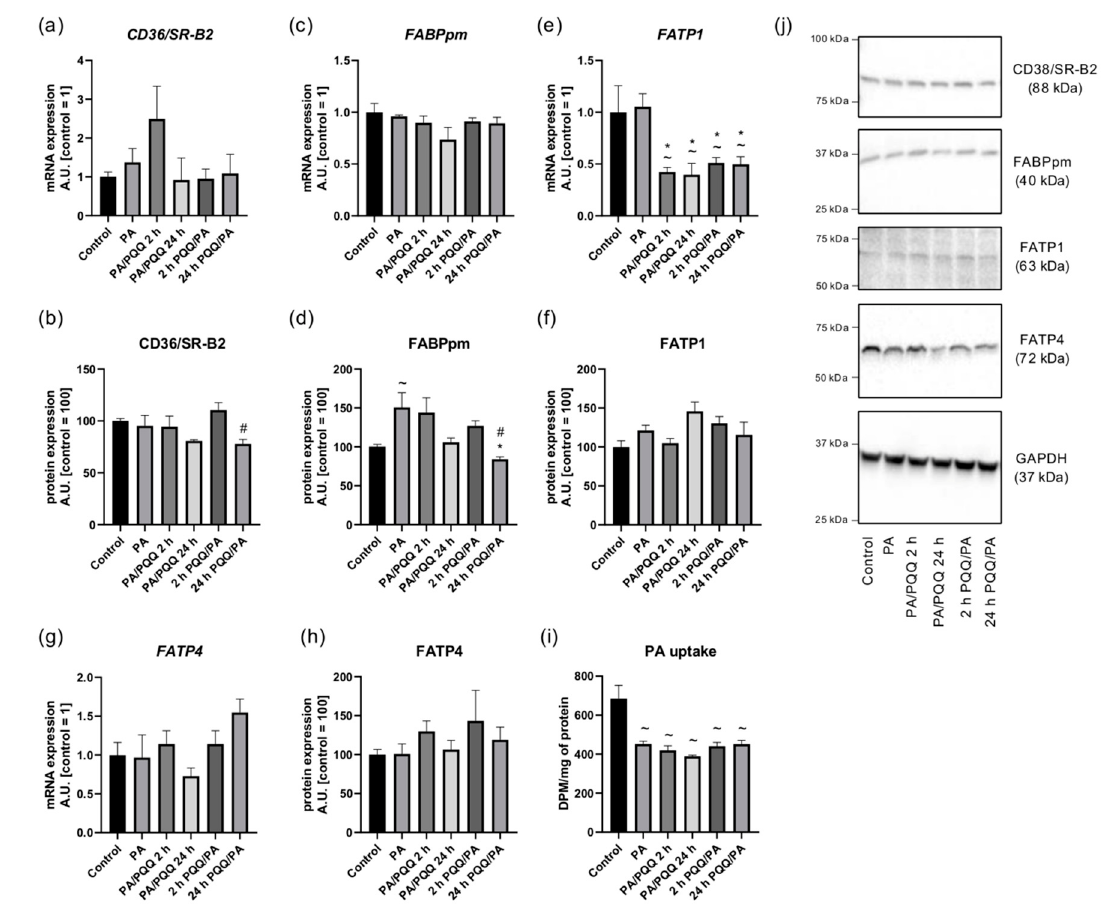
Figure 3. E ff ects of short- and long-time incubation with PQQ on the mRNA and protein levels of ( a,b ) cluster of di ff erentiation 36 / scavenger receptor class B protein, ( c,d ) plasma membrane-associated fatty acid binding protein, ( e,f ) fatty acid transport protein 1, ( g,h ) fatty acid transport protein 4 as well as ( i ) palmitic acid uptake. ( j ) Representative Western Blot data. Unless stated otherwise, the control is set as 1 (mRNA) or 100 (protein). The values are presented as mean ± SEM based on six independent determinations. ANOVA with a post hoc Tukey’s test was applied. ~ p < 0.05, study groups versus control; * p < 0.05, PQQ-incubated groups versus palmitate group; # p < 0.05, time-dependent di ff erences (long- vs. short-time incubation with PQQ). ANOVA: analysis of variance; GAPDH: glyceraldehyde 3-phosphate dehydrogenase; mRNA: messenger RNA; PA: palmitic acid; PQQ: pyrroloquinoline